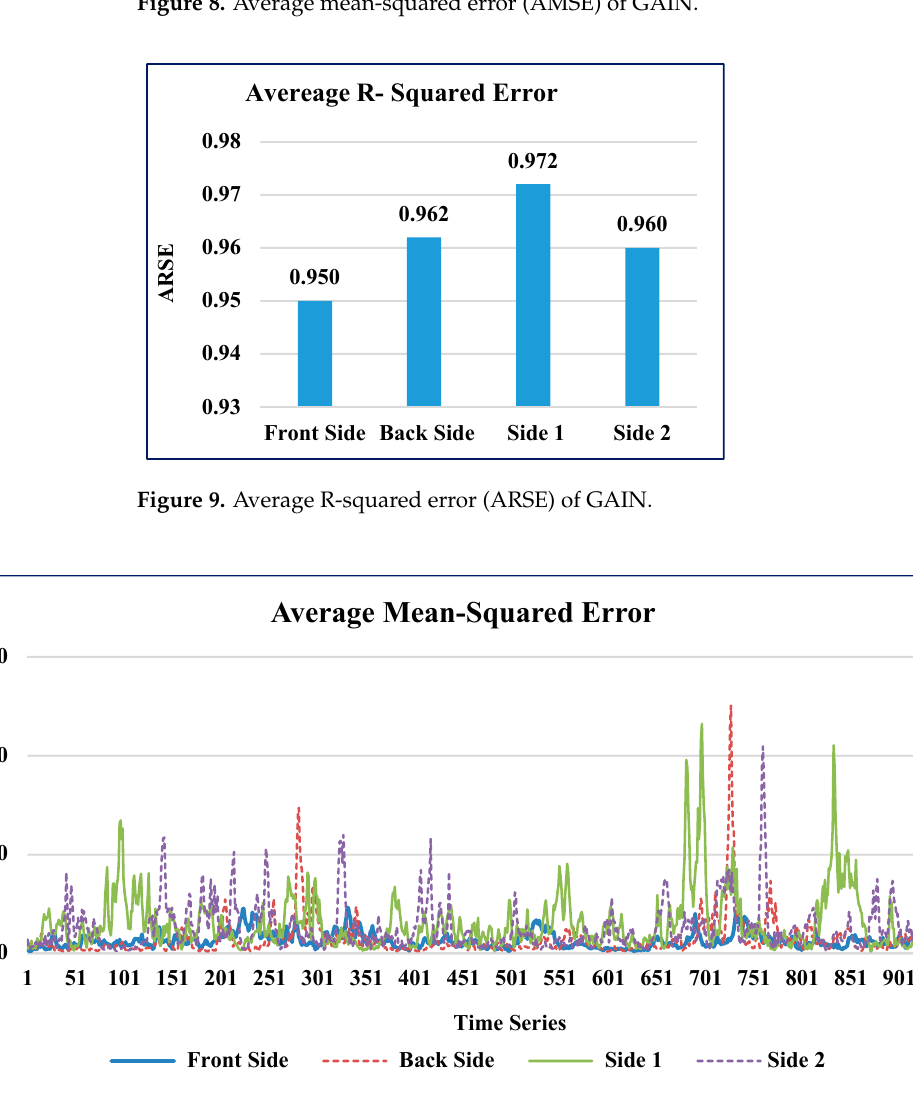
Figure 8. Average mean-squared error (AMSE) of GAIN.